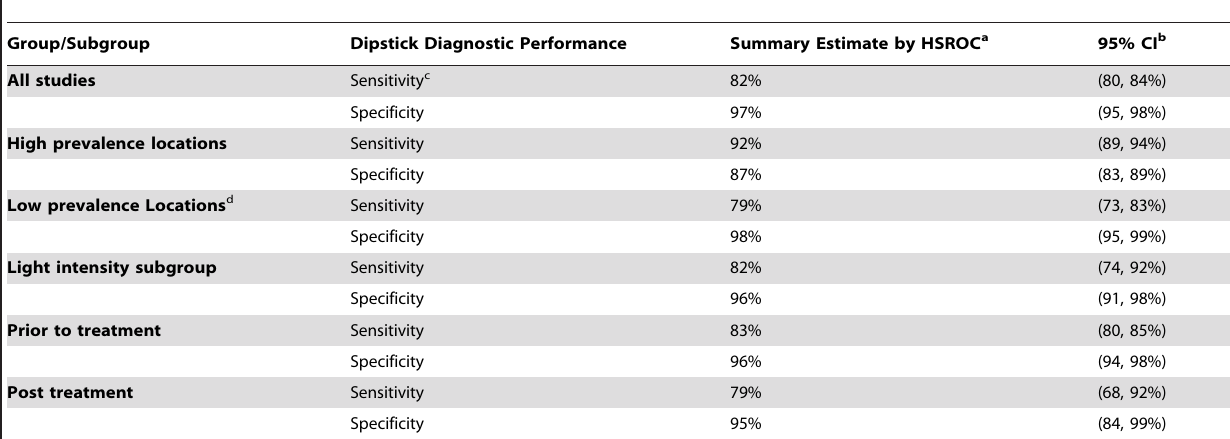
a summary estimate and. b 95% credible interval derived by Bayesian hierarchical summary receiver operating curve (HSROC) analysis [26]. c Sensitivity and specificity for detection of active S. haematobium infection, as identified by a combination of egg count and hematuria status information, assuming both tests are imperfect [26]. d Prevalence below 20%.